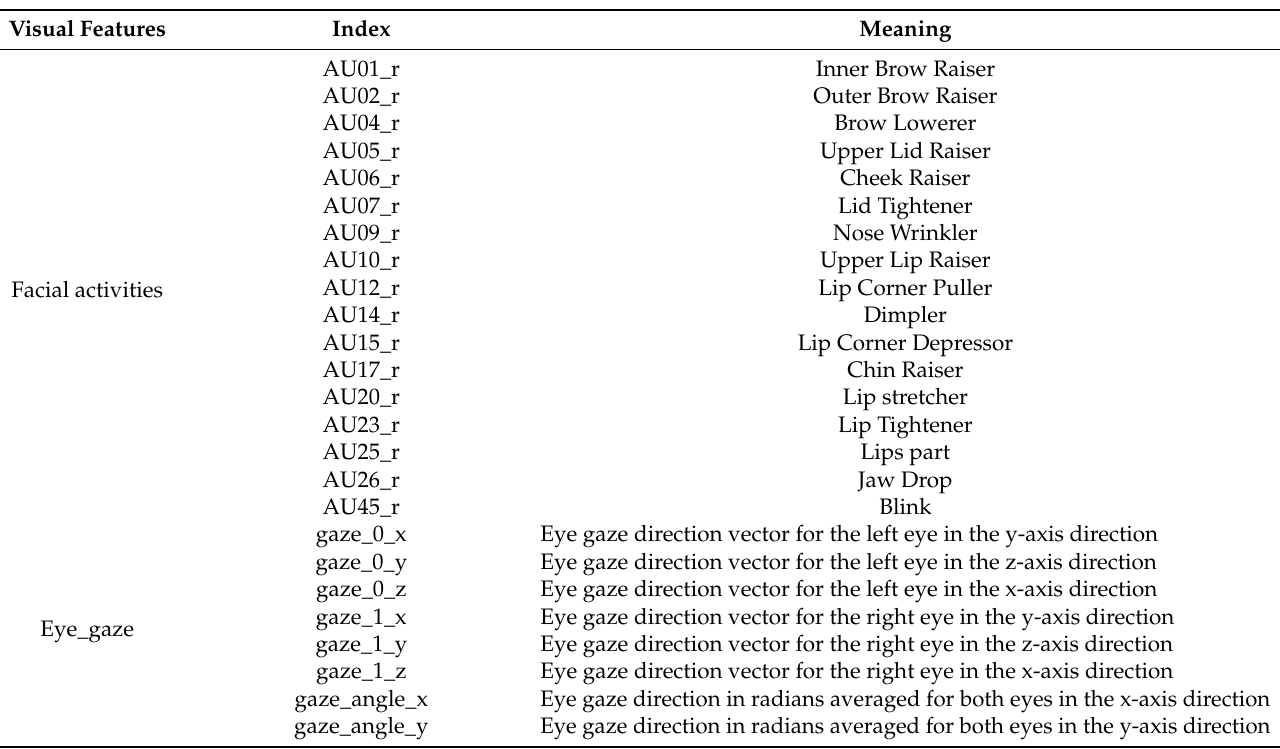
Table 1. The specific meaning of visual